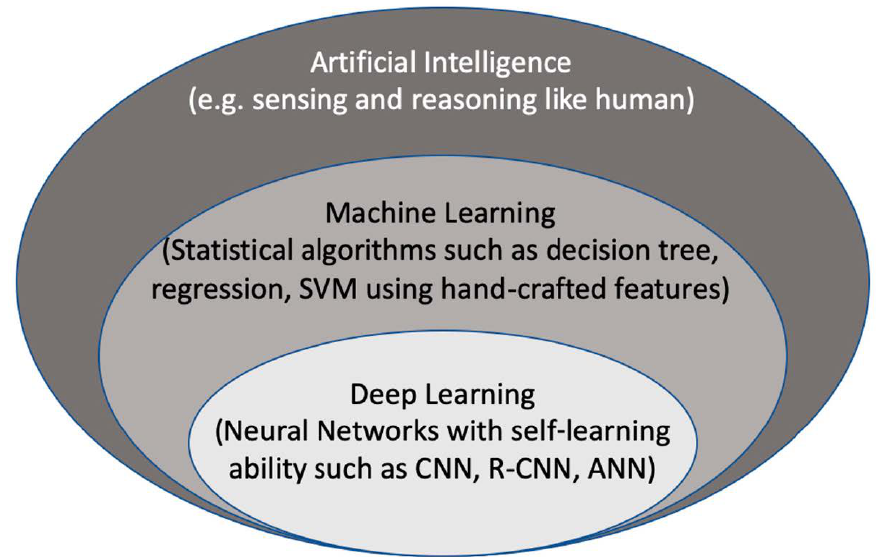
Figure 2. The context of artificial intelligence, machine learning, and deep learning. SVM: Support Vector Machine. CNN: convolutional neural networks, R-CNN: recurrent CNN, ANN: artificial neural